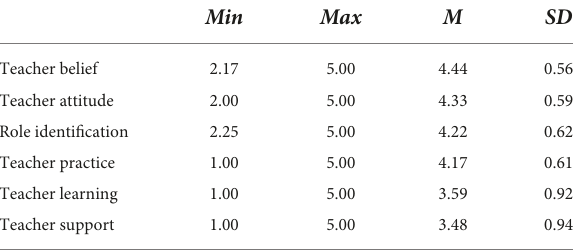
TABLE 2 Descriptive statistics of the levels of EMP teacher